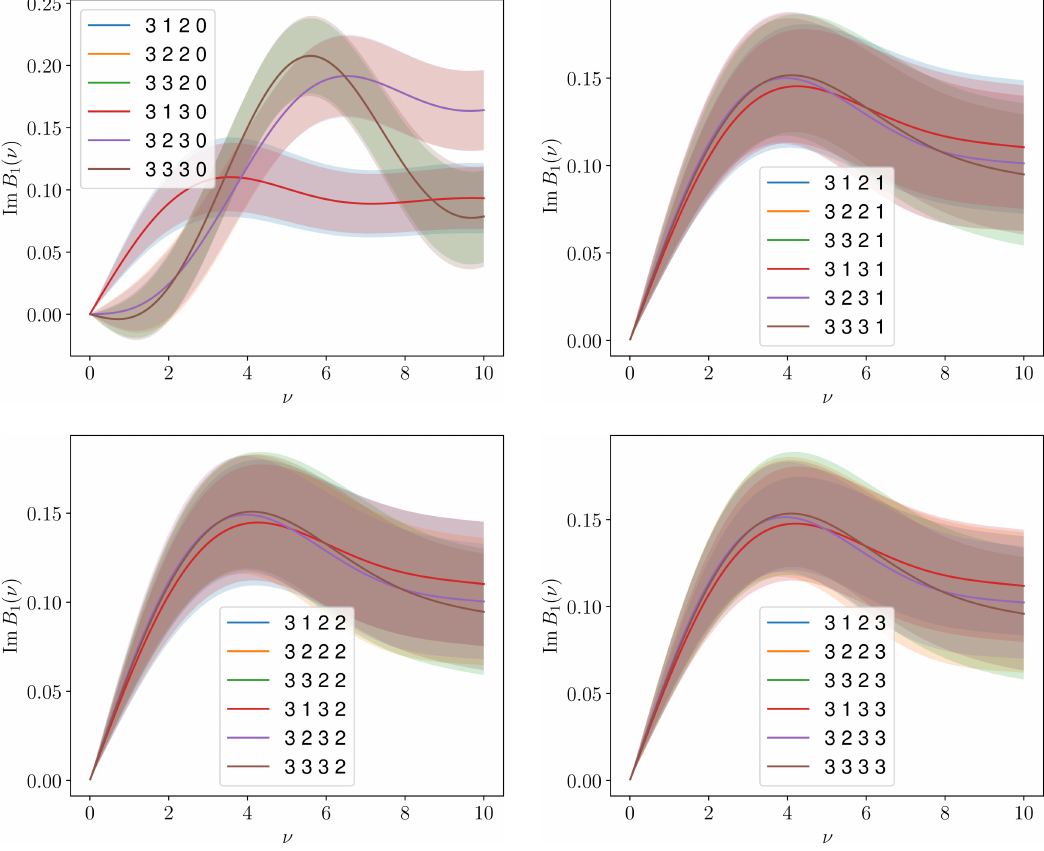
Figure 23 . The higher twist term, B 1 , results from fitting the imaginary component to the models. The numbers in the legend correspond to ( N ± , N